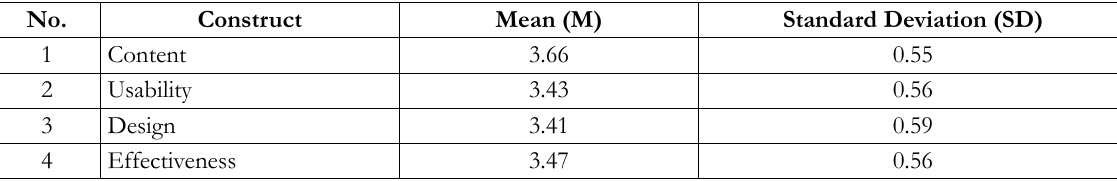
Table 7. Mean and standard deviation of constructs in perception questionnaire (Hamid,